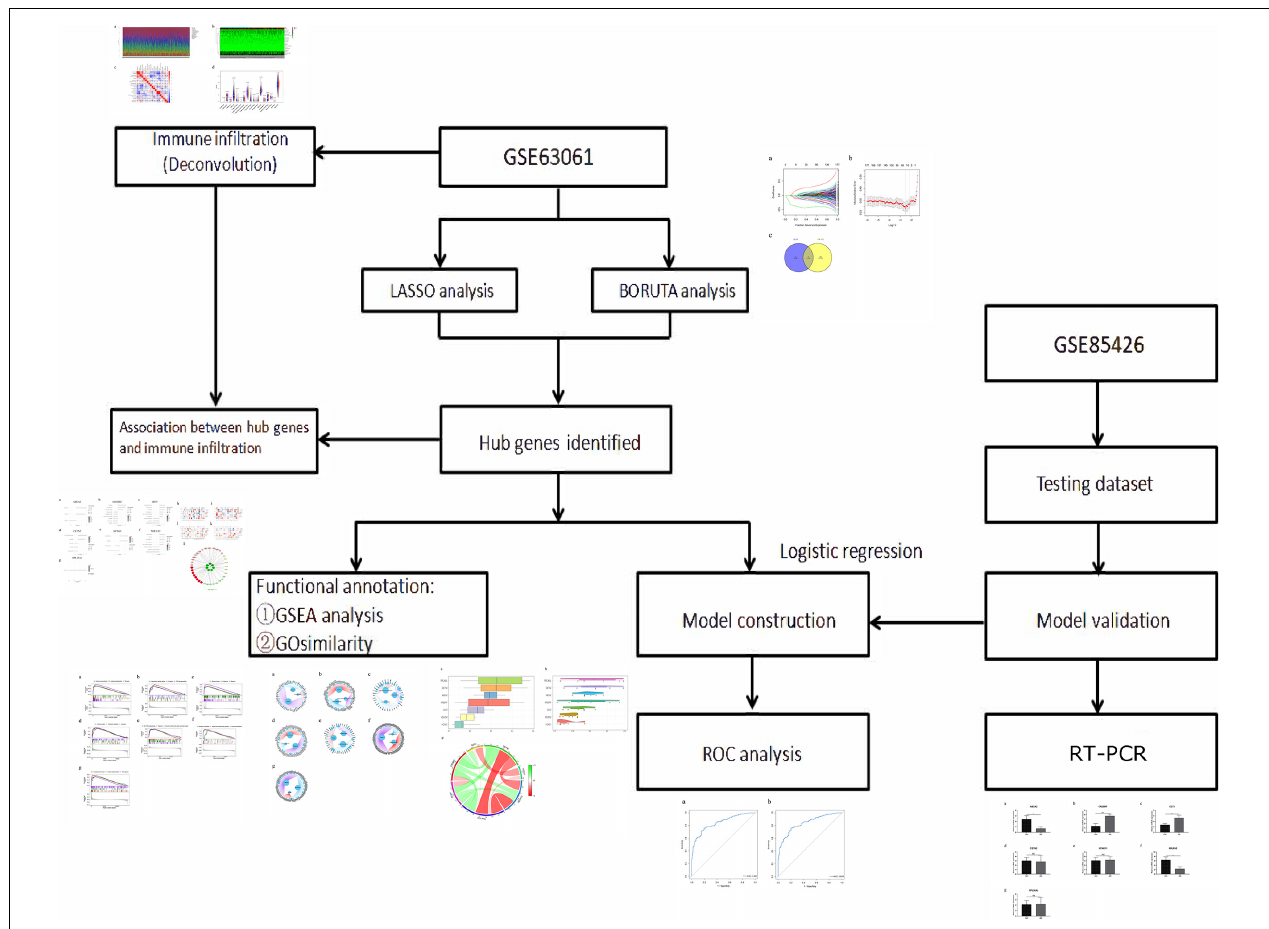
FIGURE 9 | The workflow of